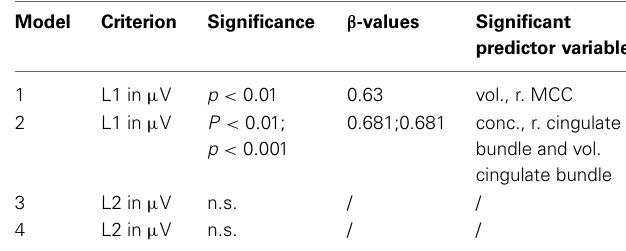
Table 1 | Overview of multiple regression